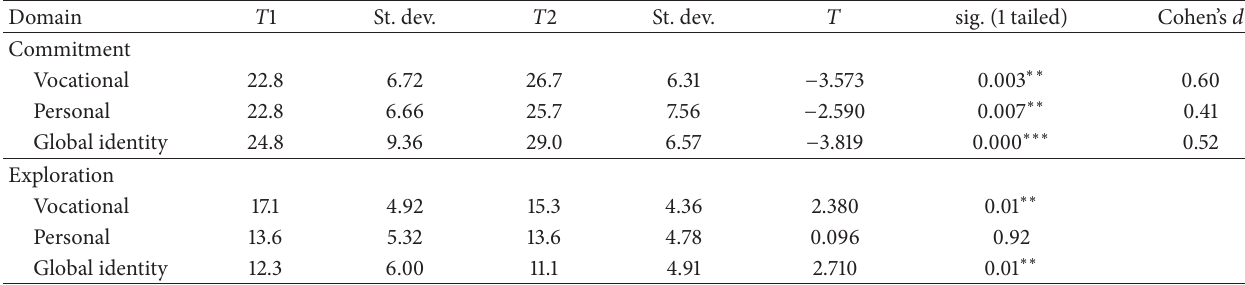
Table 1: Difference in the commitment and exploration scores per domain before ( T 1) and after ( T 2) the guidance ( 𝑛 = 45 ). Domain T 1